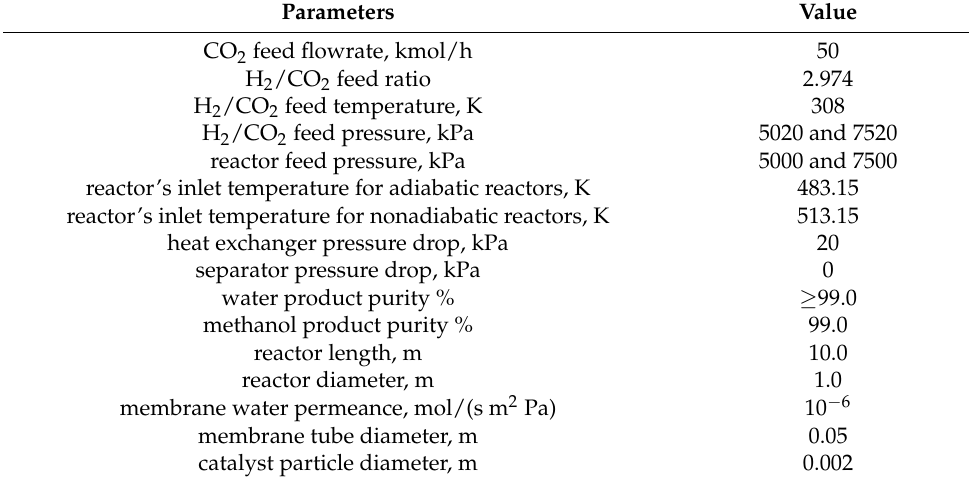
Table 2. Design data and